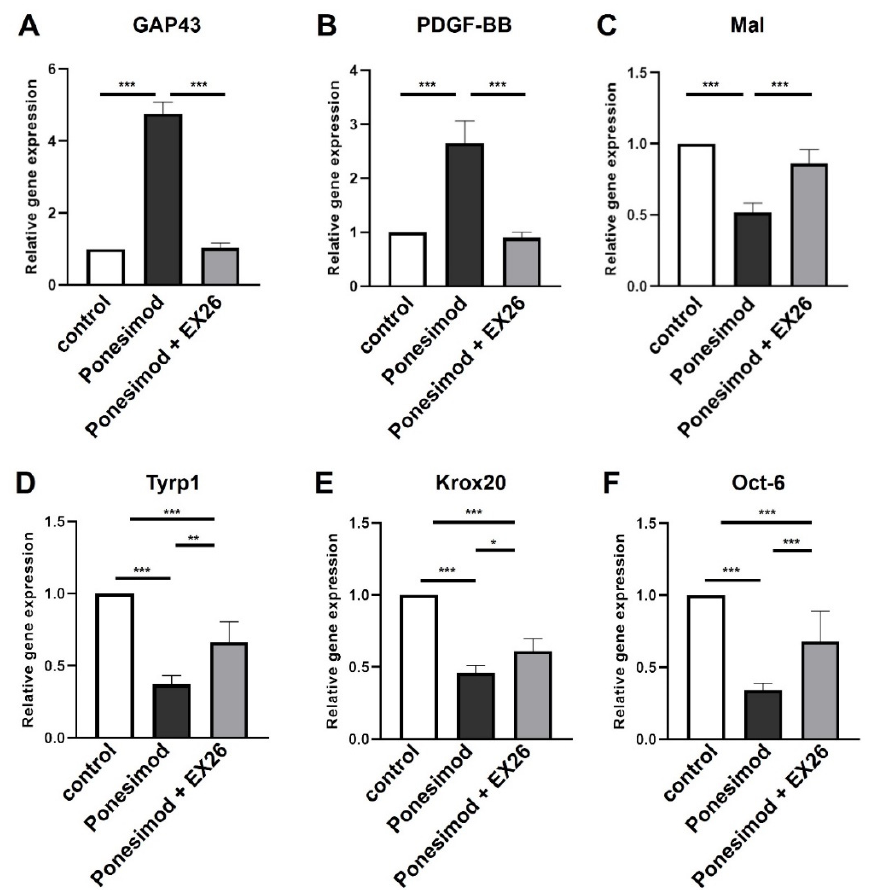
Figure 3. Ponesimod enhances the generation of a SC repair phenotype. qRT-PCR-based quantification of gene expression upon stimulation with the selective S1P1 agonist Ponesimod revealed a significant induction of GAP43 ( A ) and PDGF-BB ( B ) expression whereas Mal ( C ), Typr1 ( D ), Krox20 ( E ) and Oct-6 ( F ) expression were reduced. The combinatory treatment with EX26 almost abolished all Ponesimod-dependent effects. For statistical analysis, a one-way ANOVA with Tukey’s multiple comparison test was used, * p < 0.05, ** p < 0.01, *** p < 0.001 with at least n = 4 biological replicates. Shown are the mean values ±